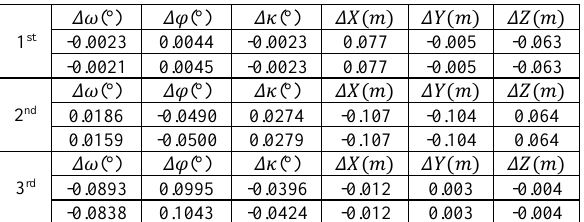
Table 2. Error comparison in Case 2.